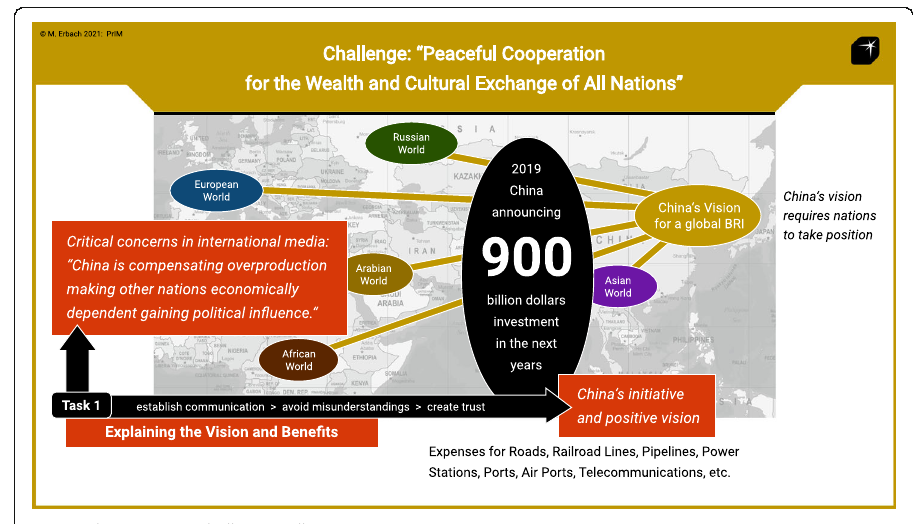
Fig. 3 China ’ s vision challenges all